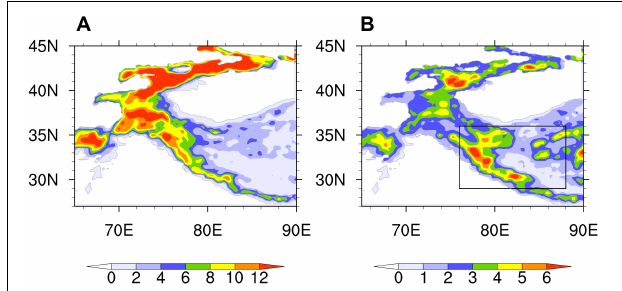
FIGURE 1 | (A) Boreal winter (DJF) mean snow depth over the western Tibetan Plateau and (B) its standard deviation during the period 1979–2015 (units: cm). The gray line outlines the 2-km topography of the Tibetan